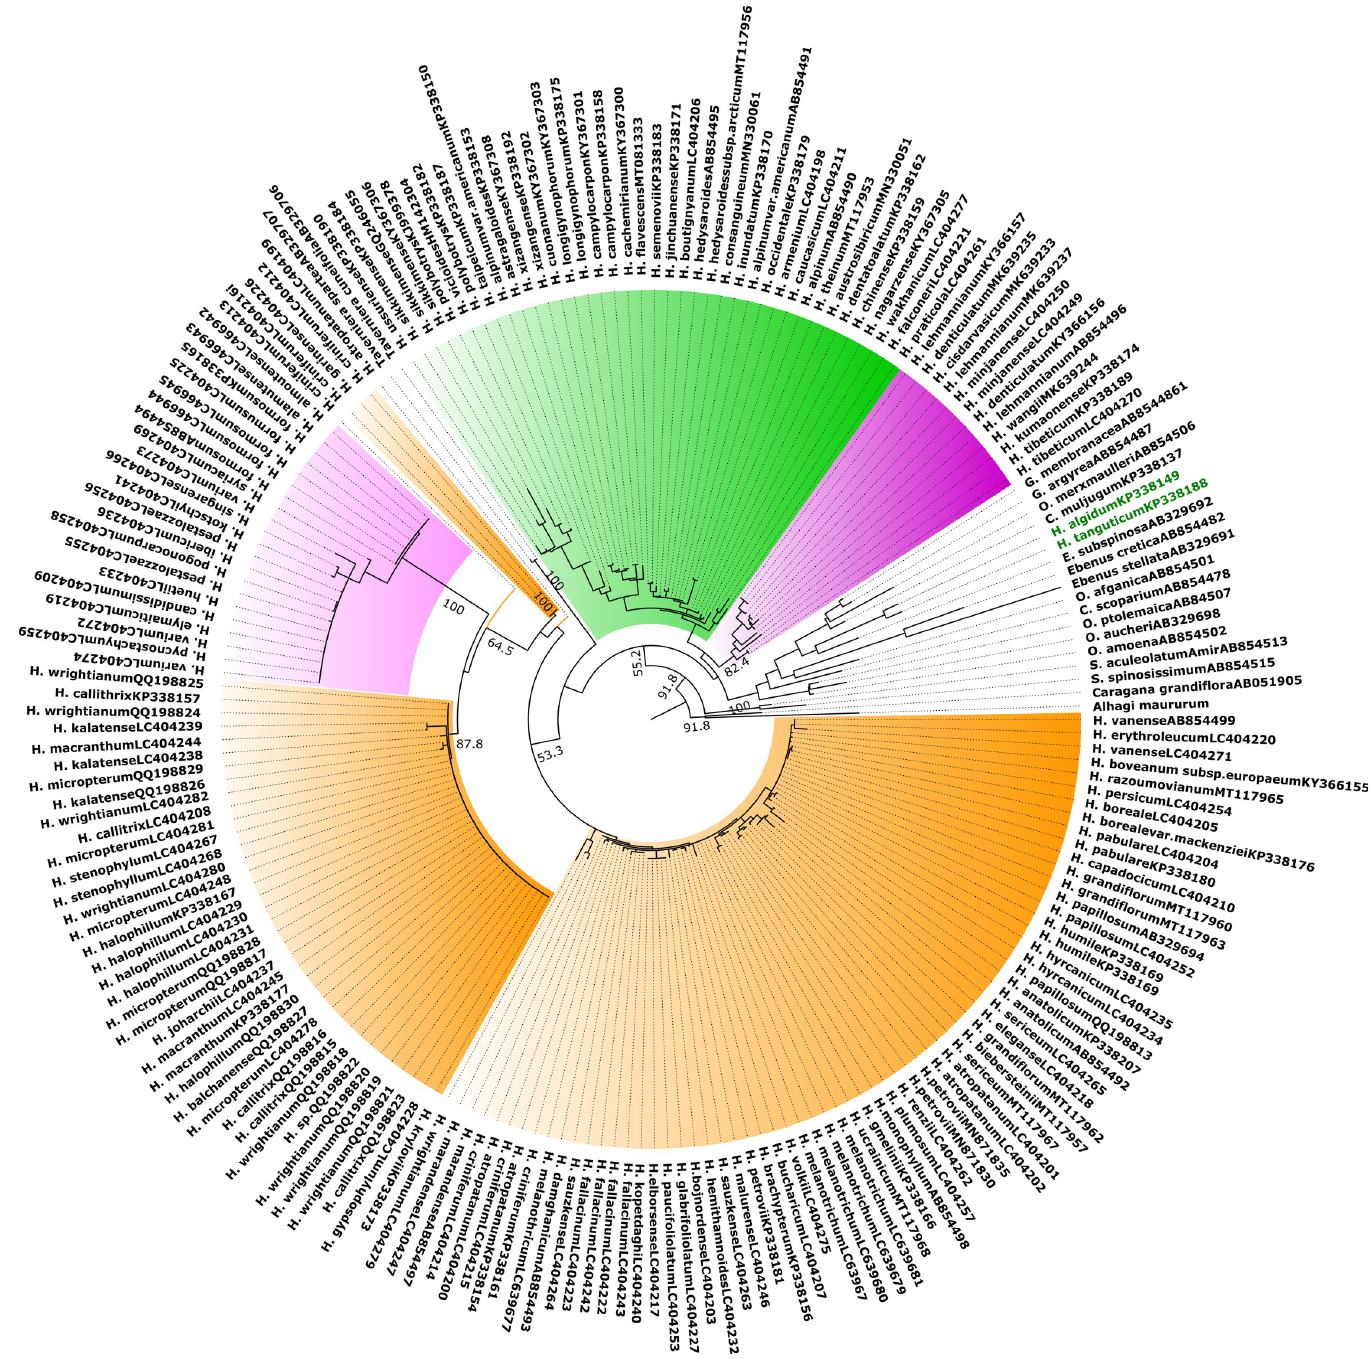
Fig 1. ITS1 sequence-structure Maximum-Likelihood tree calculated with R including a representative subset of 204 sequence-structure pairs from Hedysarum and its affiliated genera. Bootstrap support values from 1000 pseudo-replicates greater than 50% mapped at the